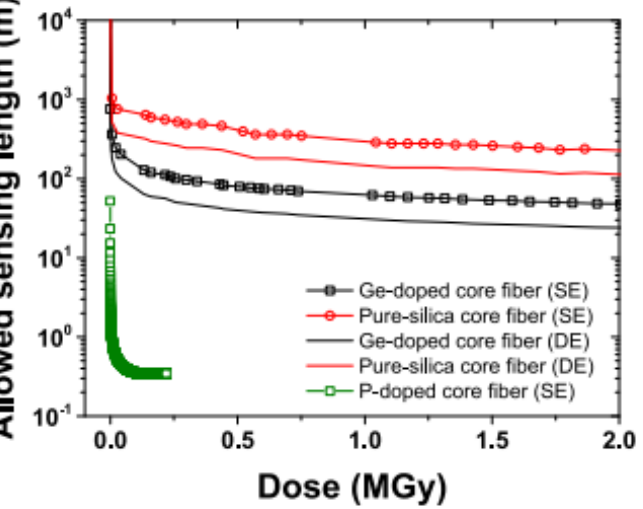
Figure 17. Sensing length decrease at increasing radiation doses for different compositions of optical fibers [15].